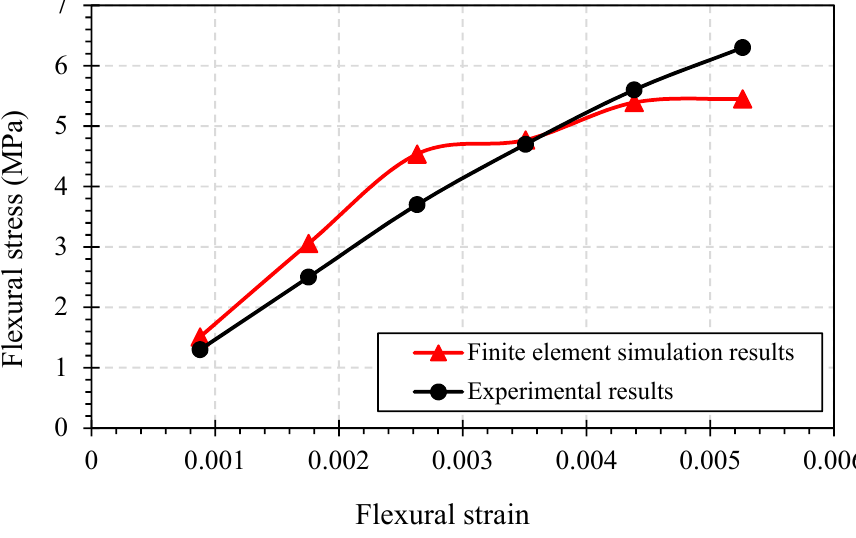
Figure 11. Plot of flexural stress vs flexural strain for experimental and finite element simulation results.